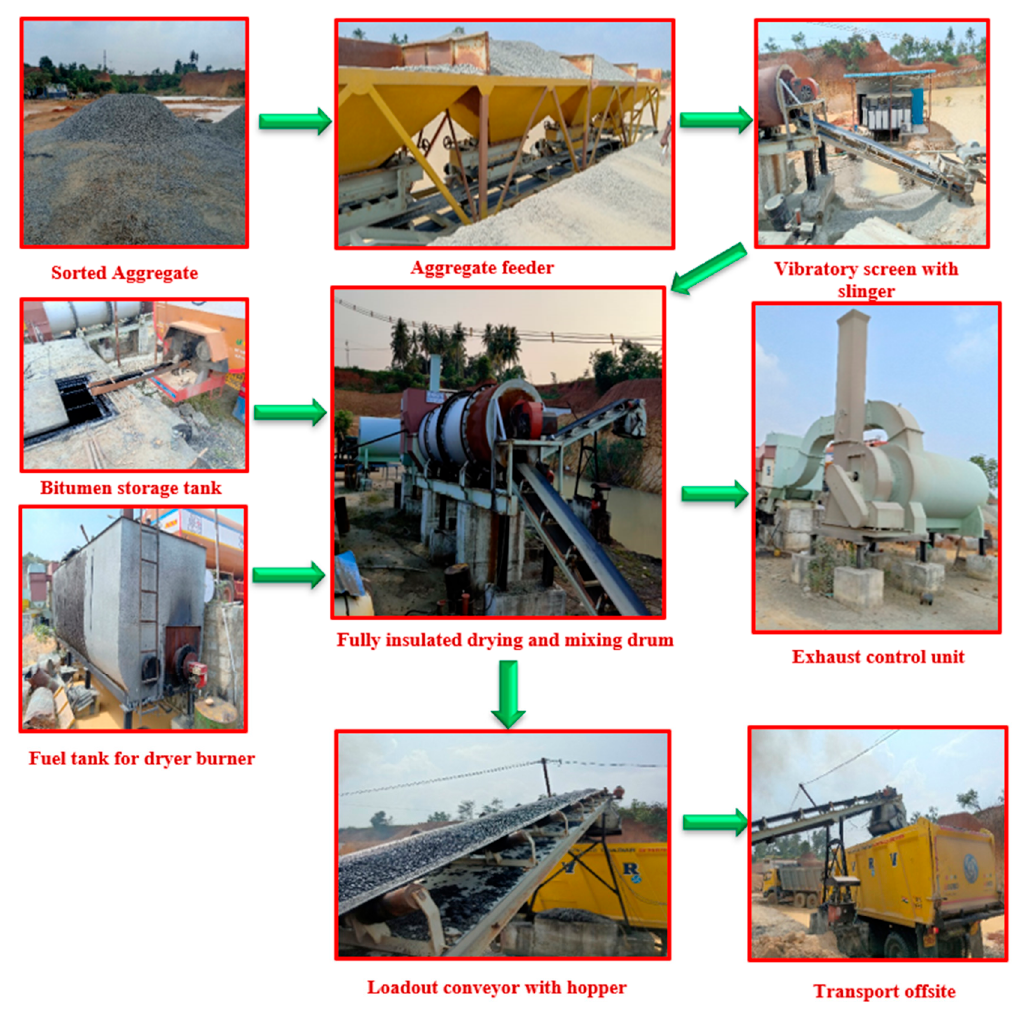
Figure 5. Preparation and production of coarse aggregate coated with asphalt.